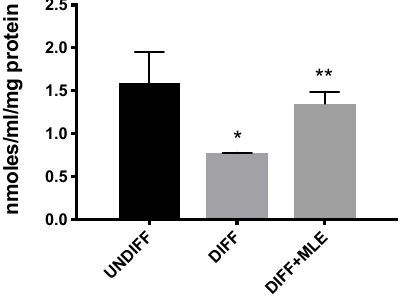
Figure 5. Glutathione cellular content after adipogenic differentiation. Bars represent the mean ± SEM of six independent experiments. * p < 0.05 versus undifferentiated cells; ** p < 0.05 versus differentiated cells.